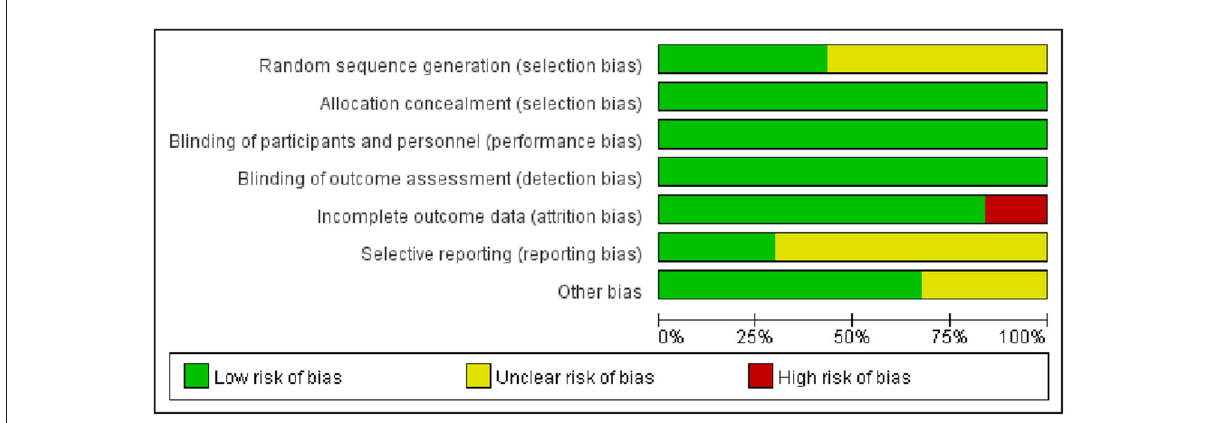
FIGURE2 Risk of bias graph of the included studies.